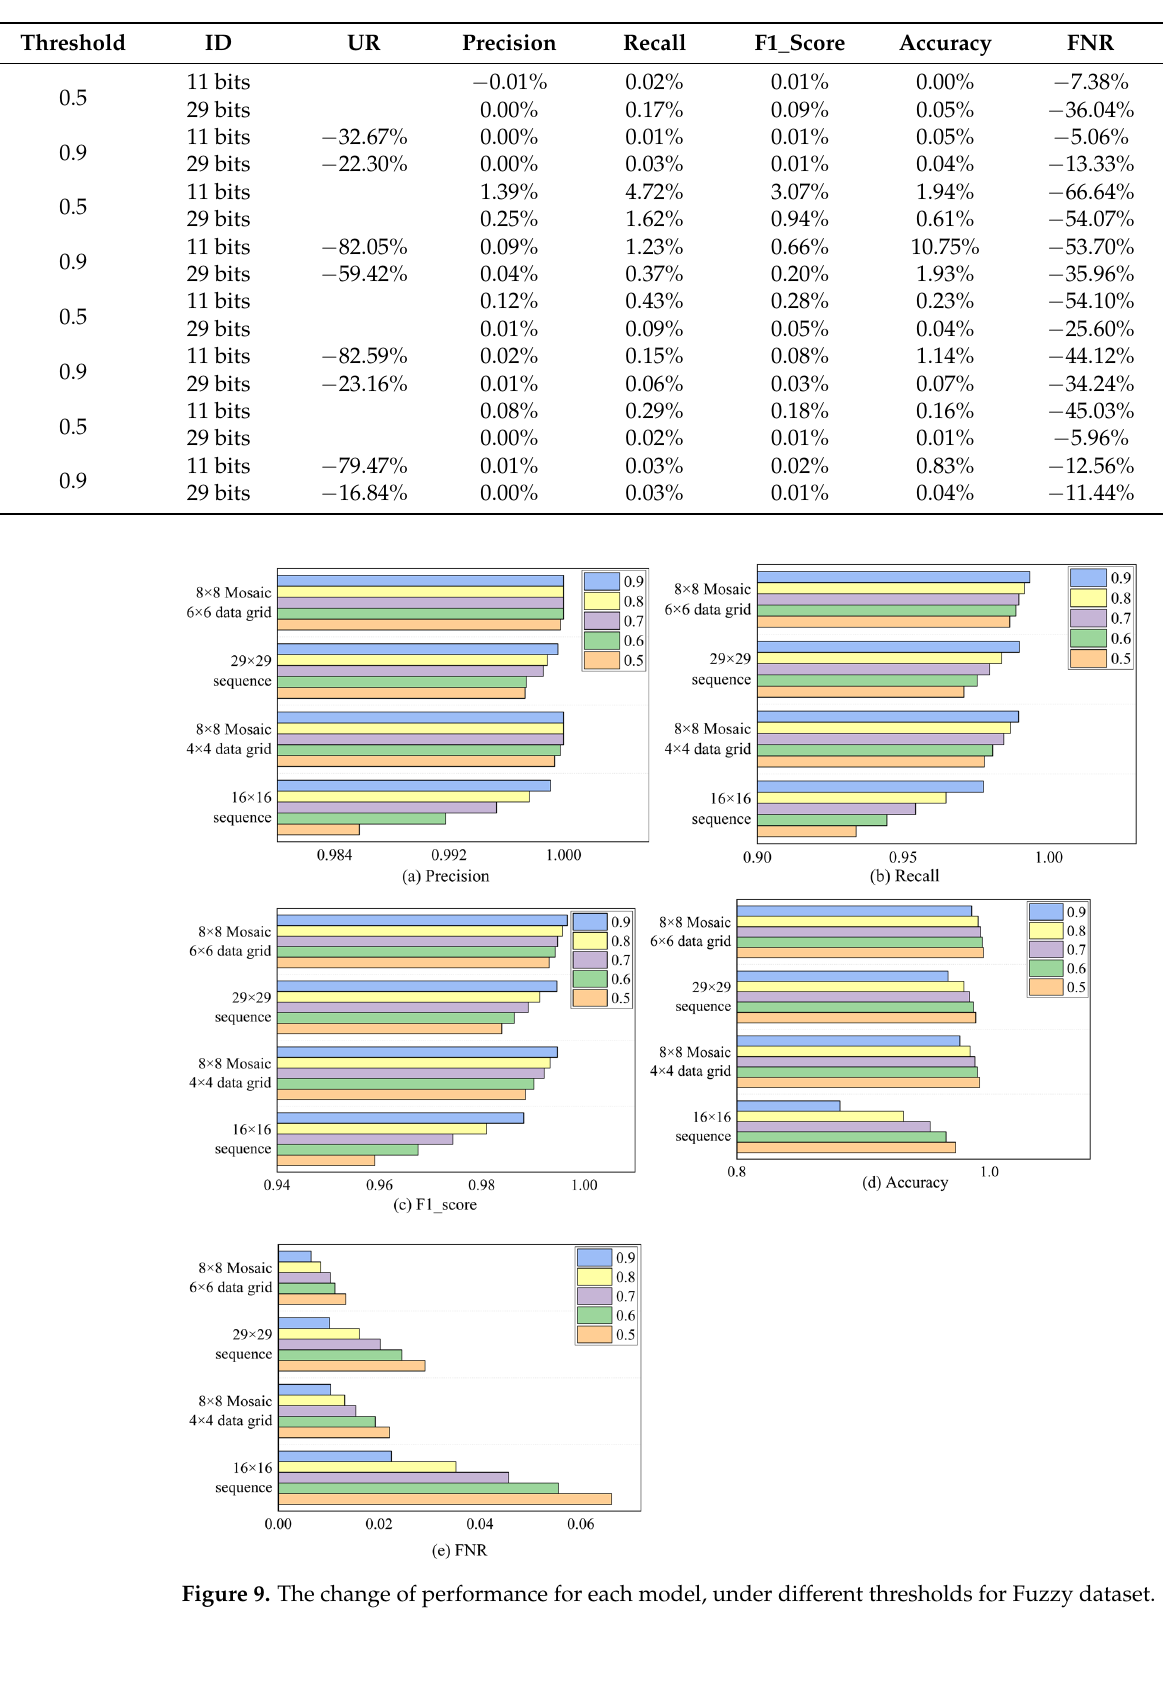
Table 4. The percentage increase for our method, over the sequential-coding method for each performance index.